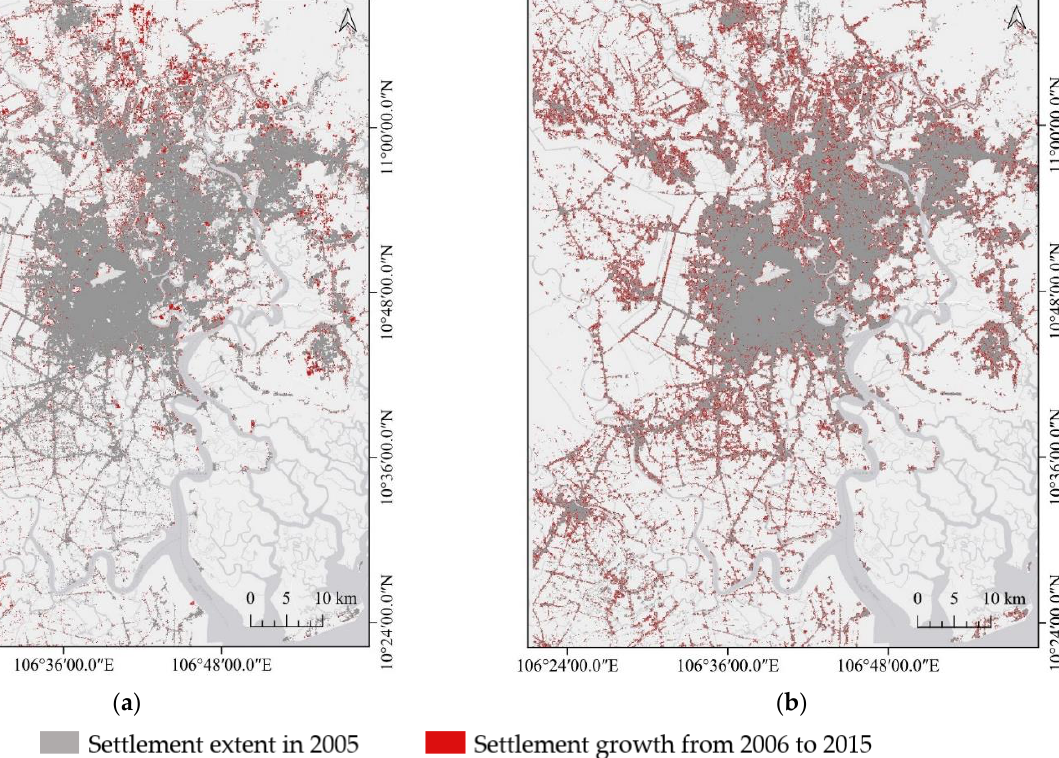
( b ) Figure 12. Actual settlement growth map and predicted settlement growth map of Abidjan based on the STM-based model from 2006 to 2015: ( a ) actual settlement growth map of Abidjan; ( b ) pre- dicted settlement growth map from based on the ten-year strategy and MLP.